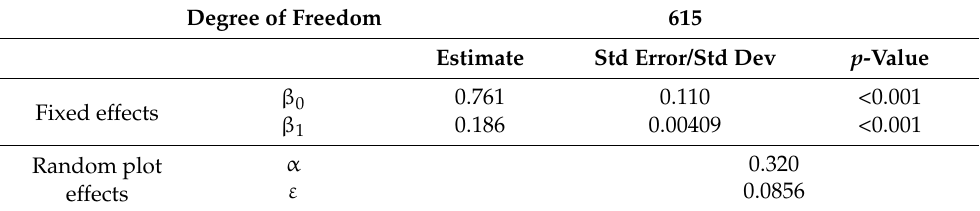
Table 3. Parameters of the mixed-effects crown model.